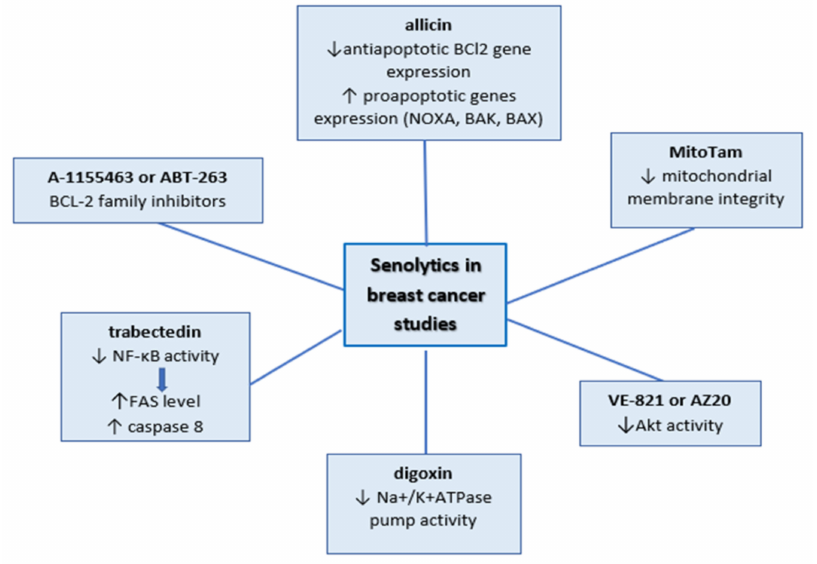
Figure 1. Senolytics tested in breast cancer